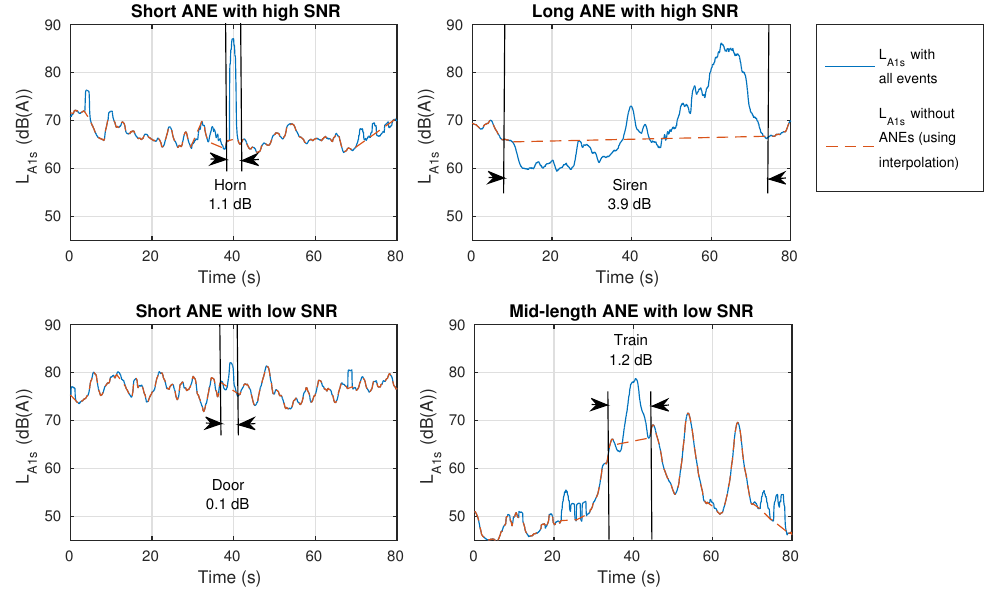
Figure 6. Four examples of ANEs showing different individual impact on the L A 5 min computation, considering a reference integration time of 1 s for resolution